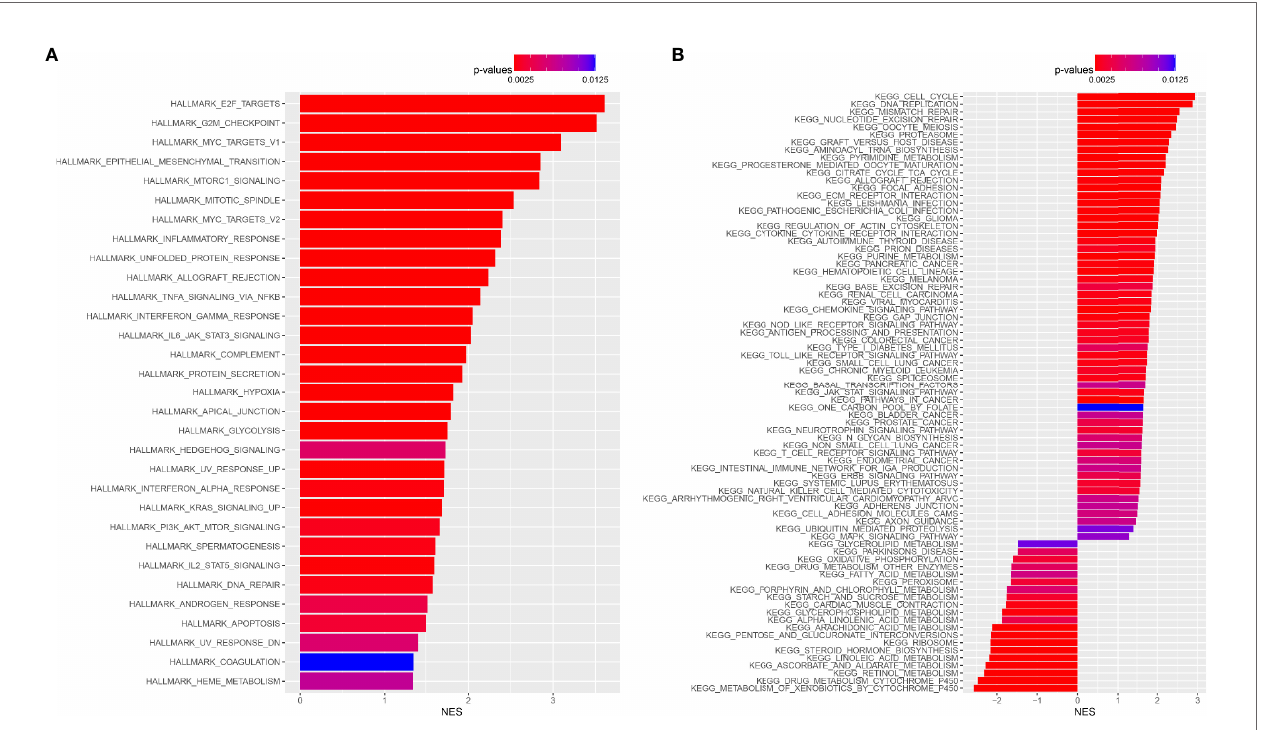
FIGURE 10 | The gene set enrichment analysis. (A) The enrichment analysis of Hallmark gene set, and the enrichment analysis of KEGG pathway (B) between the high and low nuclear MTRGs score